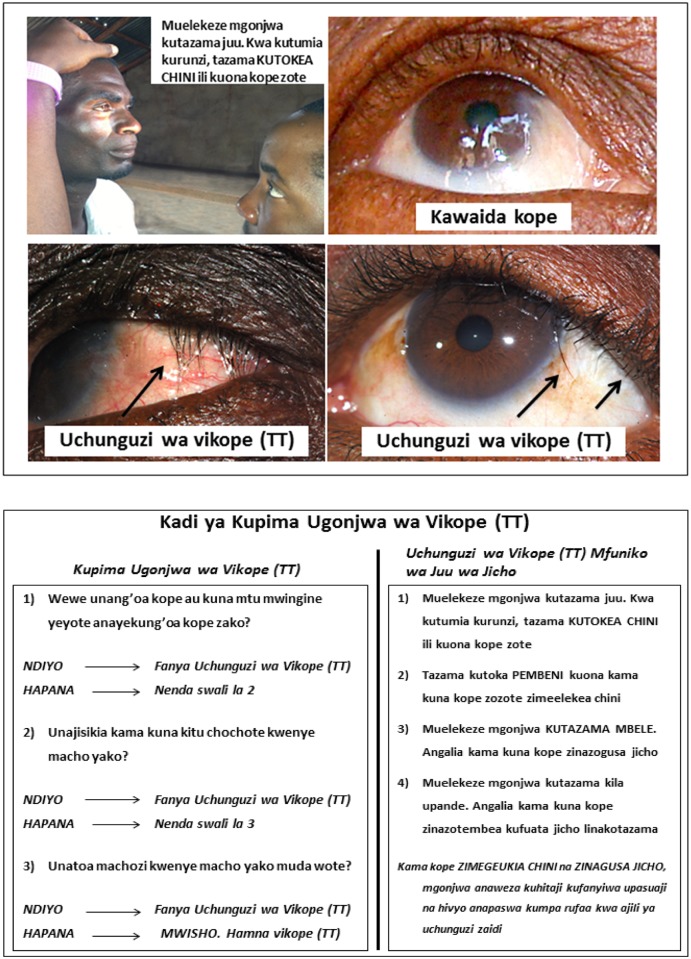
TT screening card.